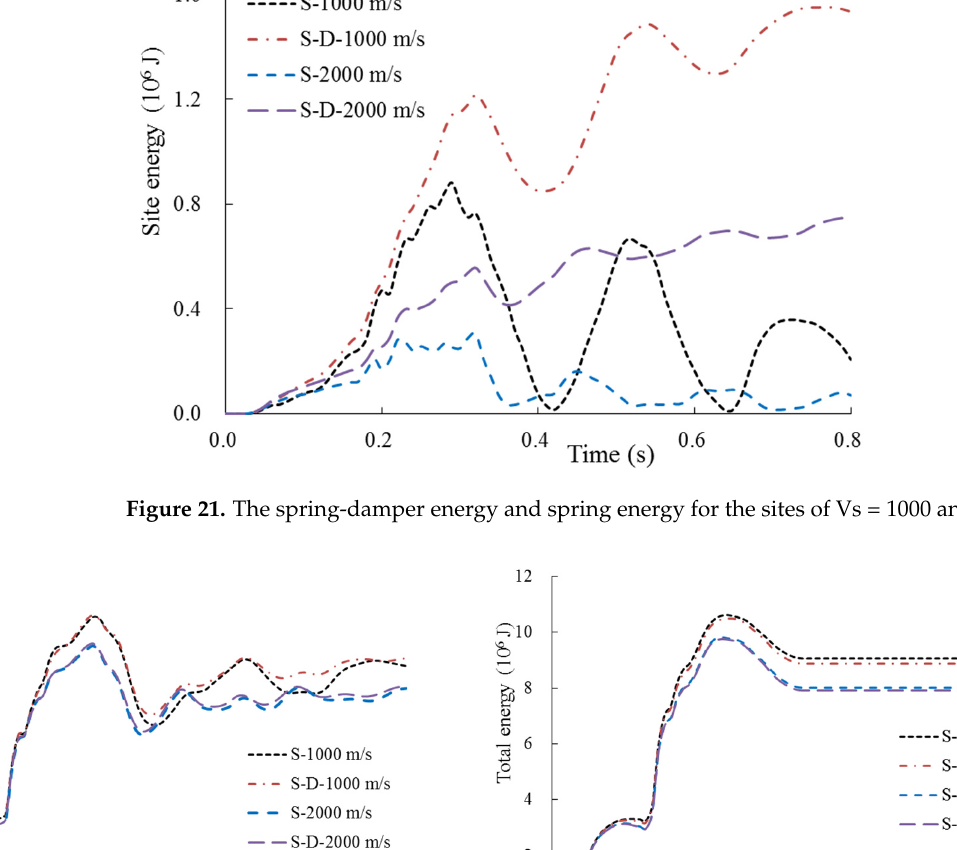
Figure 20. Max plastic strain time-histories of concrete.